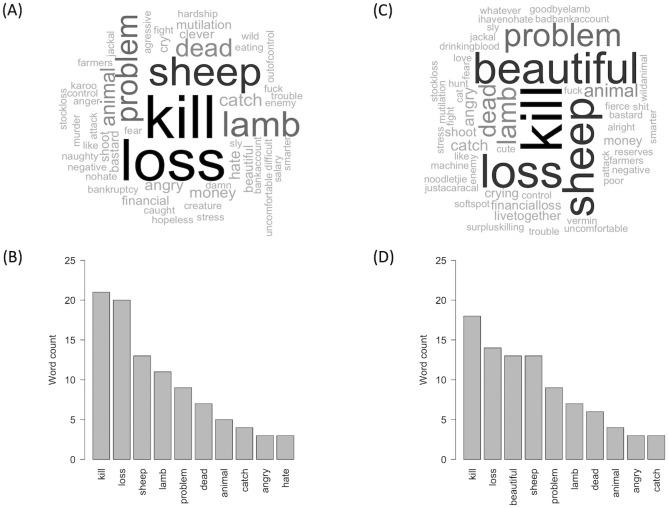
Attitude salience towards jackal and caracal.Word clouds (A, C) and corresponding histograms of the ten most frequently used words (B, D) by farmers (n = 77) when asked the question “What is the first thing you think about when I say the word jackal/caracal?”. The size of the words in the word clouds is proportional to the number of times farmers used the words in their answers. Figures (A) and (B) are for jackal, whereas figures (C) and (D) are for caracal. In Figure (A), the term “nohate” is used to represent the sentence “I have no hate for the jackal”.